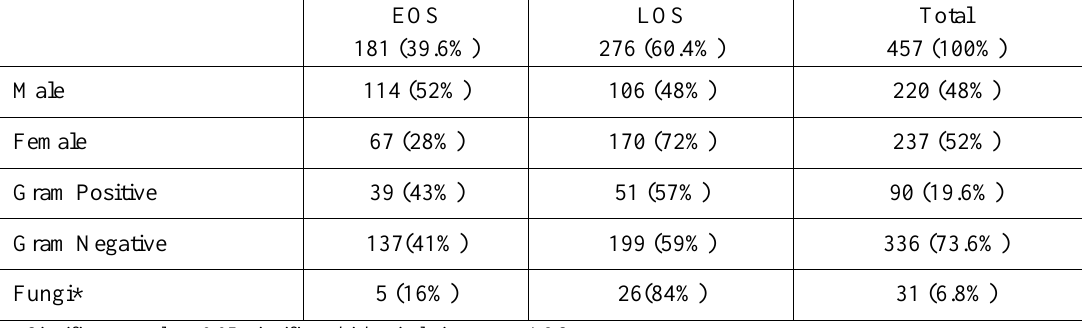
Table 1 . Demographic data and sample description.